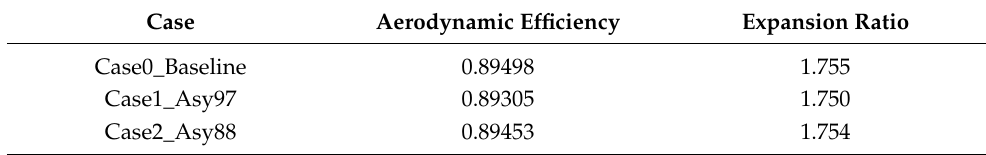
Table 7. Aerodynamic performance of different asymmetric